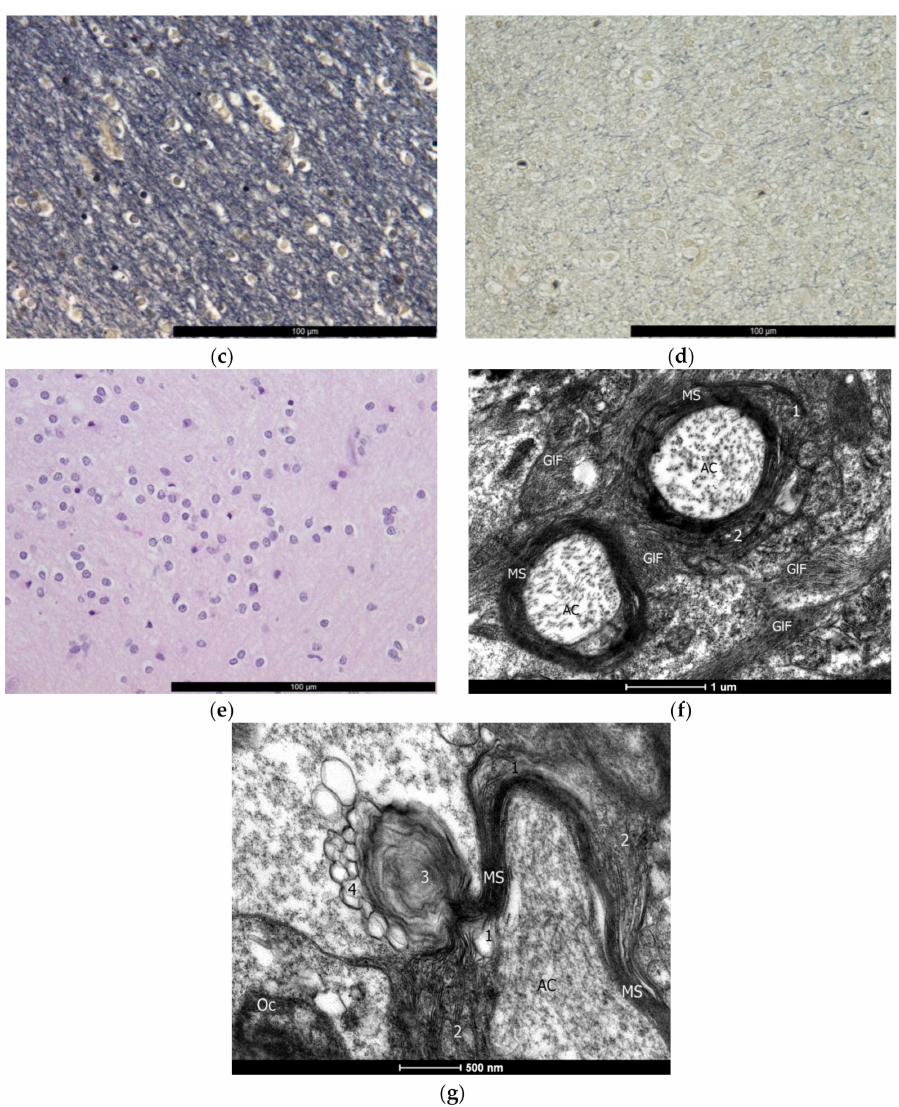
Figure 1. Structural changes in the epileptic focus in the temporal lobe. Light microscopy: ( a ) neurons in the cerebral cortex in the comparison group; ( b ) loss of neurons in the cerebral cortex in a patient with DRE (Nissl staining, 200 × ); ( c ) white matter rich in myelin in the comparison group; ( d ) white matter demyelination in a patient with DRE (Spielmeier staining, 200 × ); ( e ) white matter, gliosis (HE, 400 × ). TEM: (f) destruction of myelin sheaths; bar, 1 µ m; 16,500 × ; ( g ) destruction of myelin sheaths; bar, 500 nm; 26,500 × . 1, areas of lamella rupture; 2, delamination of the sheath; 3, myelin dissociation; 4, vesicular disintegration; 5, grainy myelin disintegration; GlF, gliofibrils; Oc, oligodendrocyte; AC, axial cylinder, axon; MS, myelin